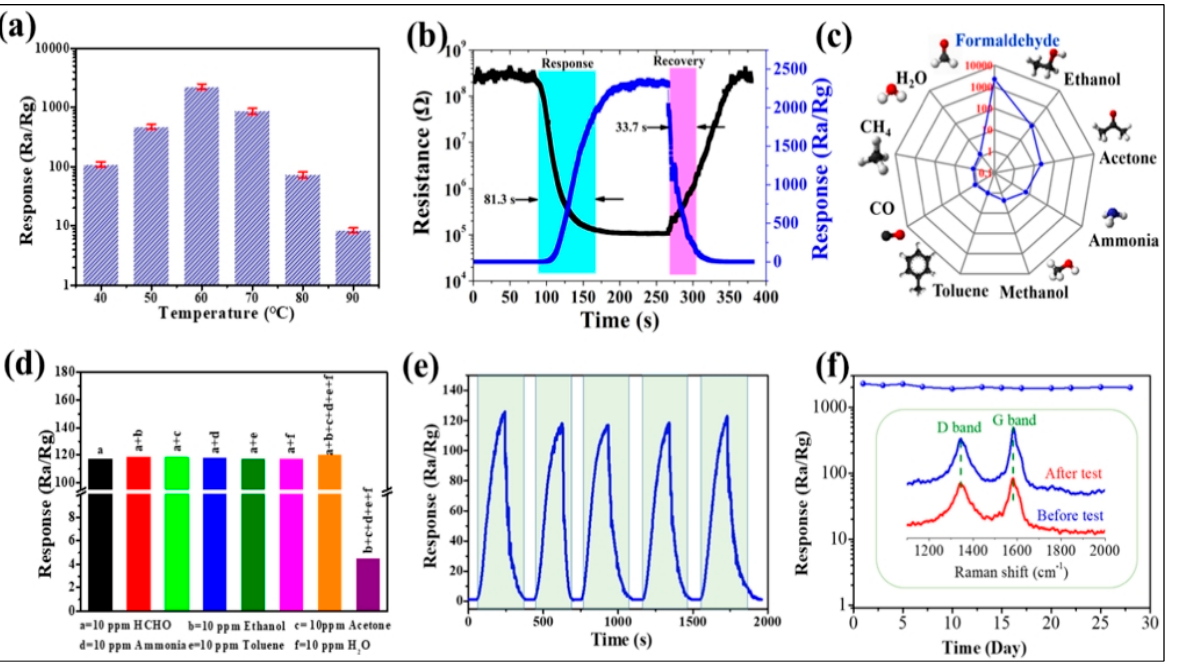
Figure 11. ( a ) Sensor responses of GO/SnO 2 nano-sheets toward 100 ppm HCHO ( b ) response/recovery graphs of the responses of the sensor based on GO/SnO 2 ( c ) polar graphs of responses of GO/SnO 2 nano-sheets sensor toward different gases ( d ) responses of the GO/SnO 2 nano-sheets sensor toward mixture ( e ) reproducibility of GO/SnO 2 nano-sheets toward mixed gases ( f ) stability of the sensor based on the responses of GO/SnO 2 nano-sheets toward 100 ppm HCHO at 60°C, the inset shows the Raman spectra of GO/SnO 2 nano-sheets. (Reprinted [166] copyright 2019 American Chemical Society).